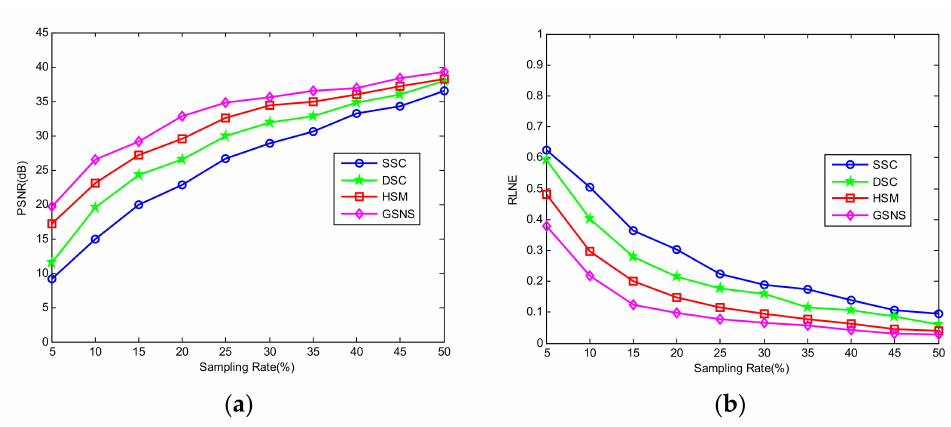
Figure 4. Comparison of the PSNR and RLNE curves to different sampling rates. ( a ) PSNR; ( b )